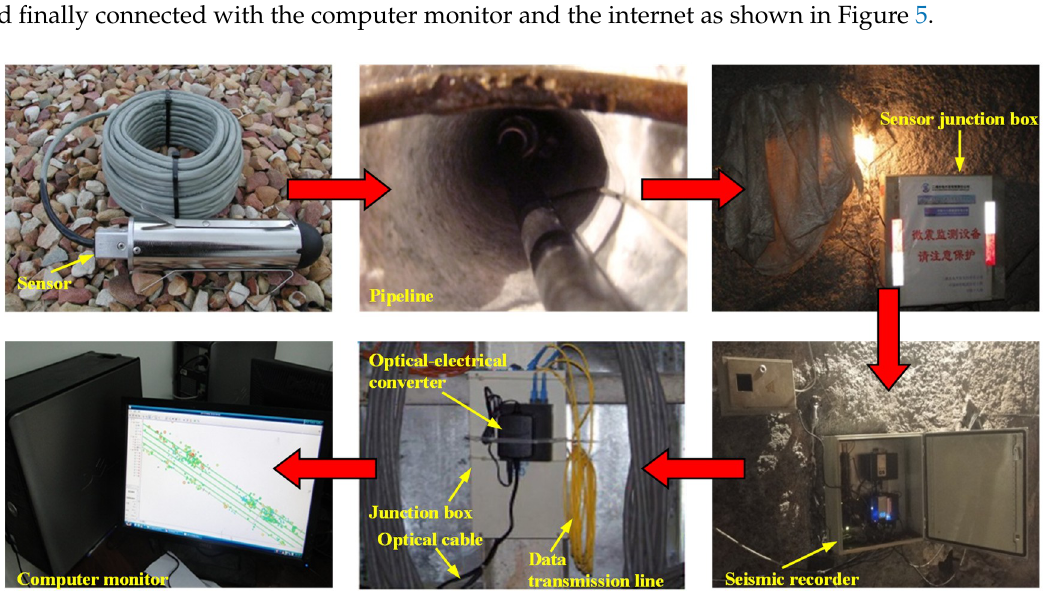
Figure 5. The connection of monitoring equipment.